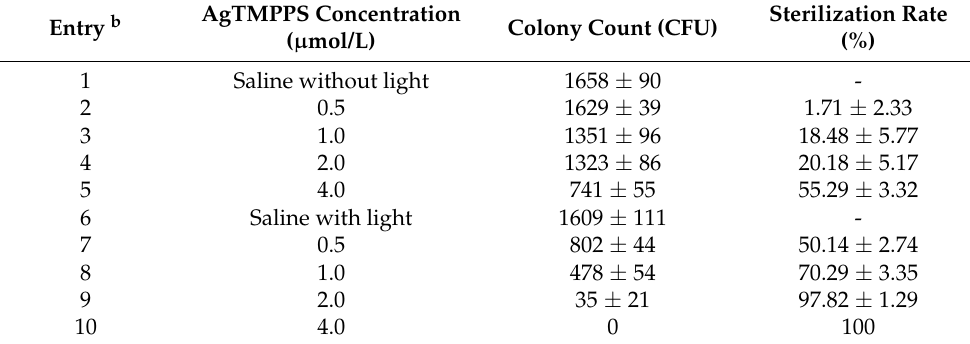
from Corning (Corning, NY, USA) or BioFil (JET, Guangzhou,